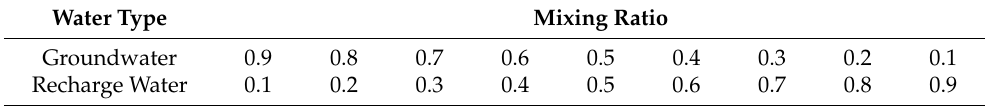
Table 3. Recharge Schemes with Different Mixing Ratios.